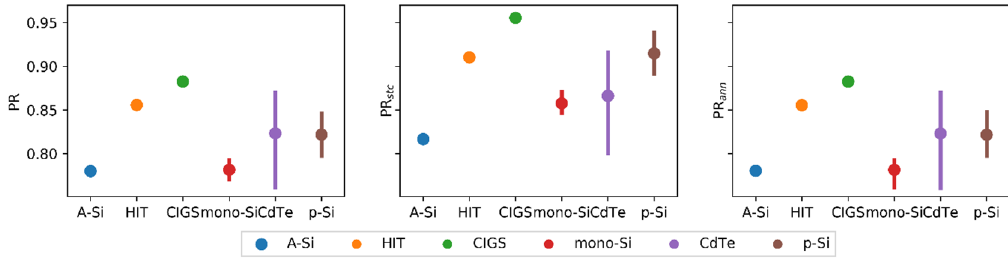
Figure 7. Performance ratio by technology.